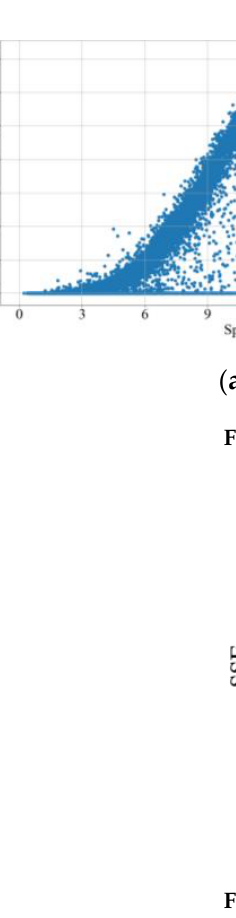
Figure 7. Schematic diagram of class selection for future prediction points.